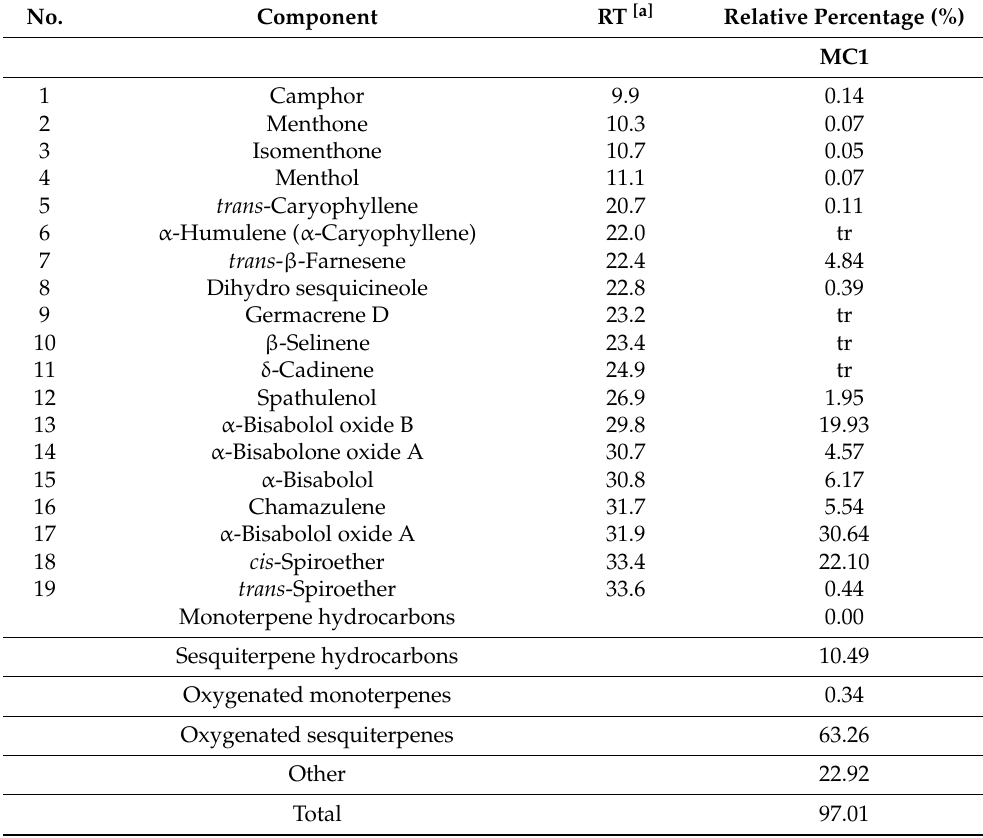
Table 3. GC-MS profile of EOs obtained from Asteraceae